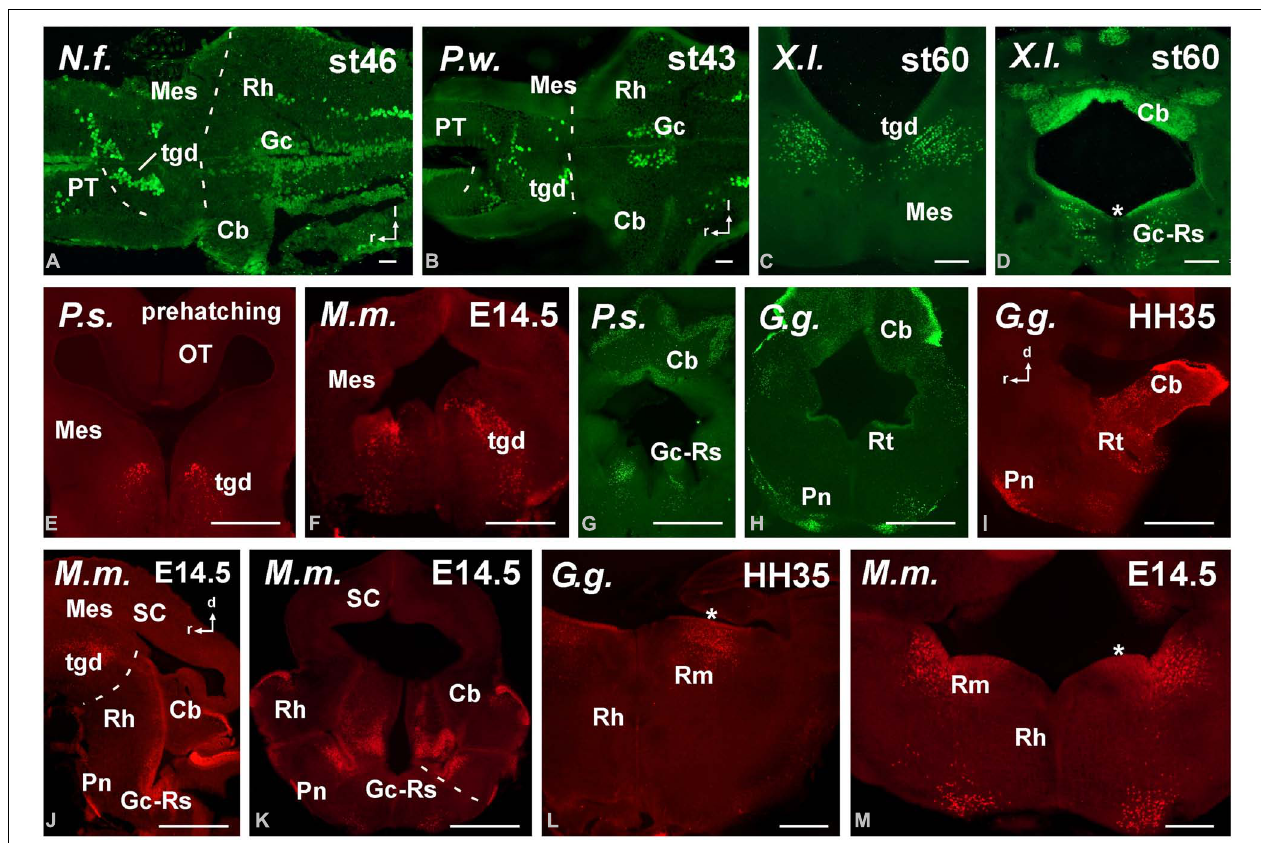
FIGURE 6 | Photomicrographs of horizontal (A,B), transverse (C–H,K–M) and sagittal (I,J) sections at mesencephalic and rostral rhombencephalic levels that illustrate the localization of Pax6-immunoreactive cells in the dorsal mesencephalic tegmentum in anamniotes (A–C) and amniotes (E,F). The cerebellum showed Pax6-ir cells in all the models analyzed (A,G,H,J) . In the rostral